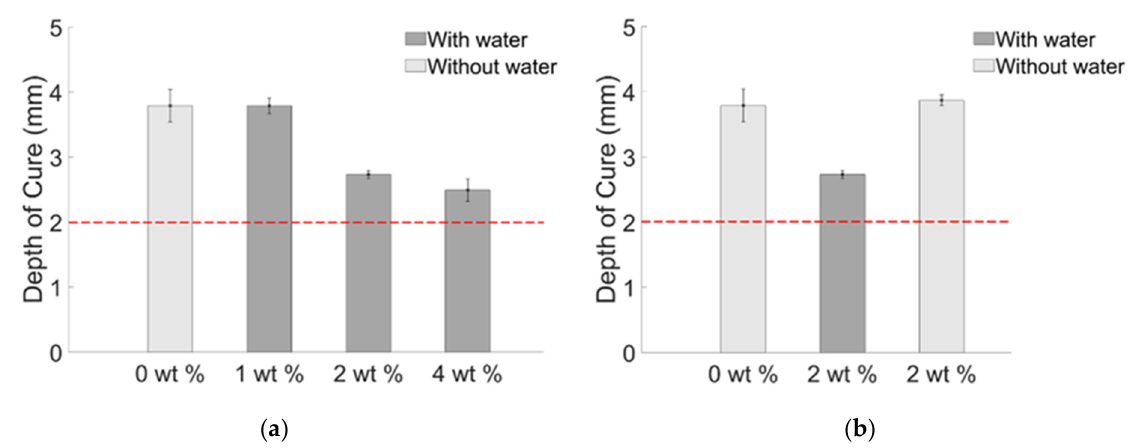
Figure 6. Depth of curing properties of composite ( a ) with water ( b ) with and without water. The red line indicates the minimum curing depth required for in-vivo application.